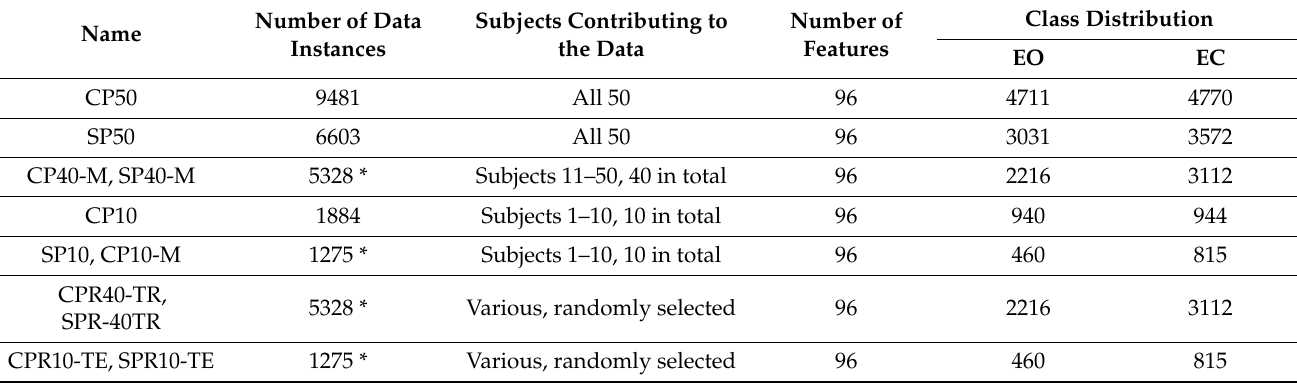
Figure 1. A schematic of the dataset generation process and the dataset naming scheme. Table 1. Detailed information about the generated